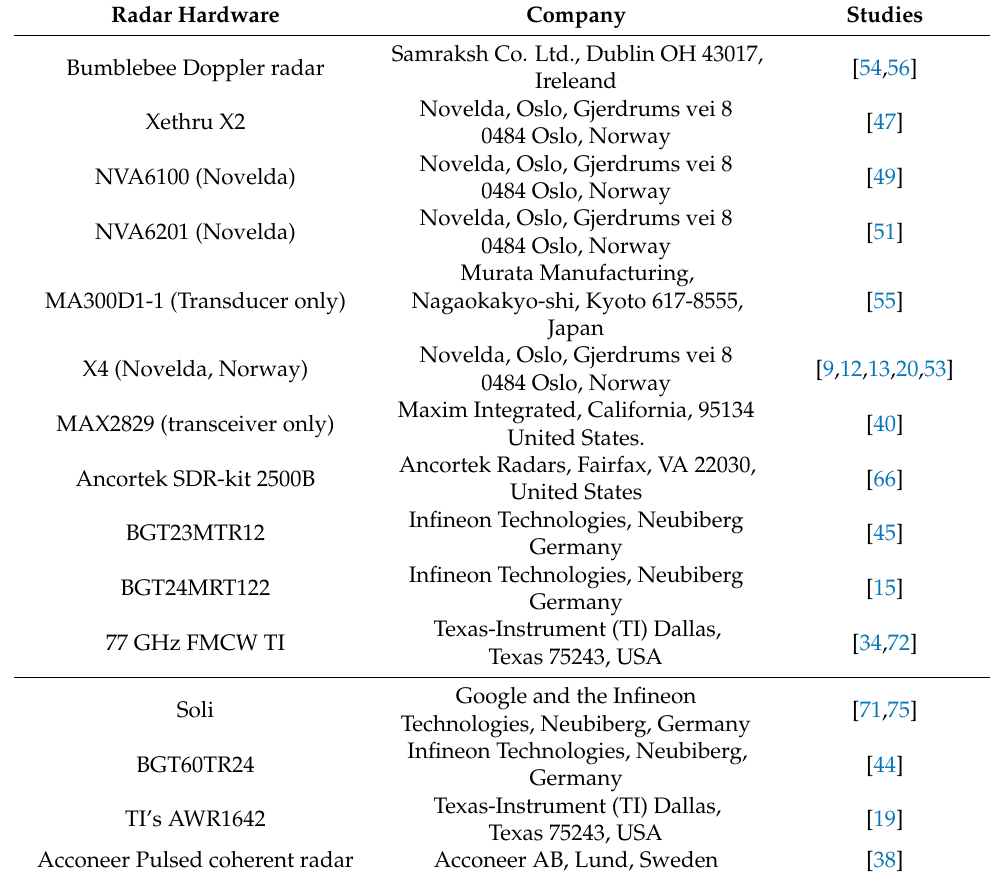
Table 7. Summary of developed applications using Radar